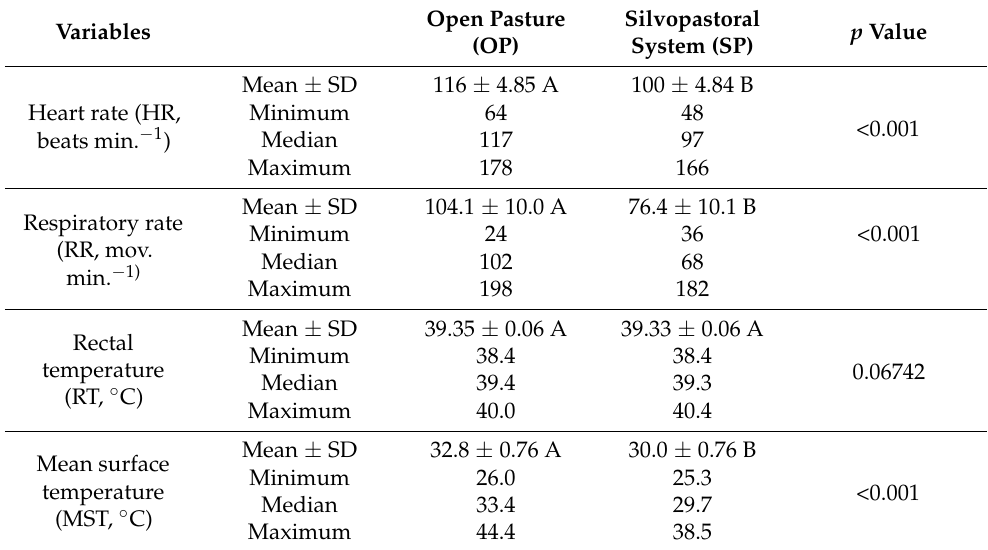
Table 2. Physiological variables between rearing systems throughout the summer (mean ± SD; median, maximum,